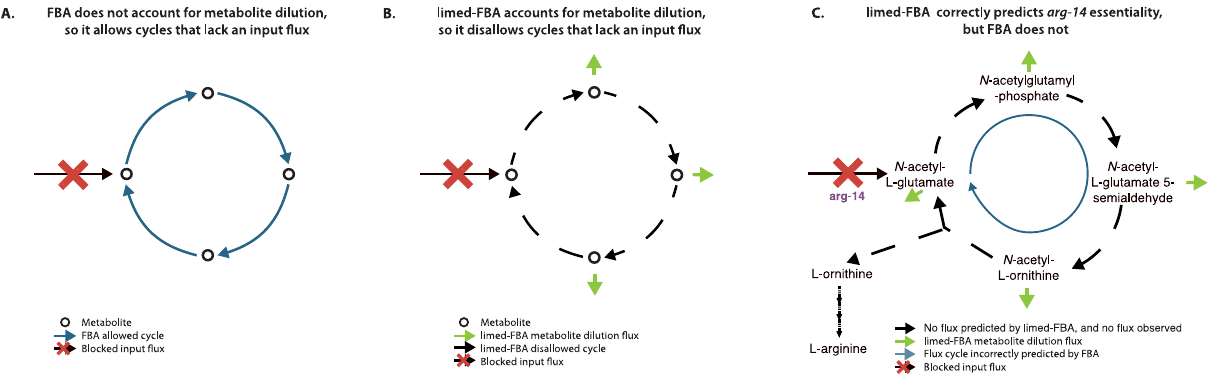
Figure 2. limed-FBA vs FBA. (A) FBA does not require an input flux for cycles because it does not account for dilution of metabolites that participate in active reactions. (B) limed-FBA requires an input flux for cycles to compensate for dilution of metabolites that participate in active reactions. (C) FBA fails to correctly predict arg-14 gene essentiality because without an input flux, metabolite dilution prevents the isolated acetyl cycle compounds from being produced (side compounds not